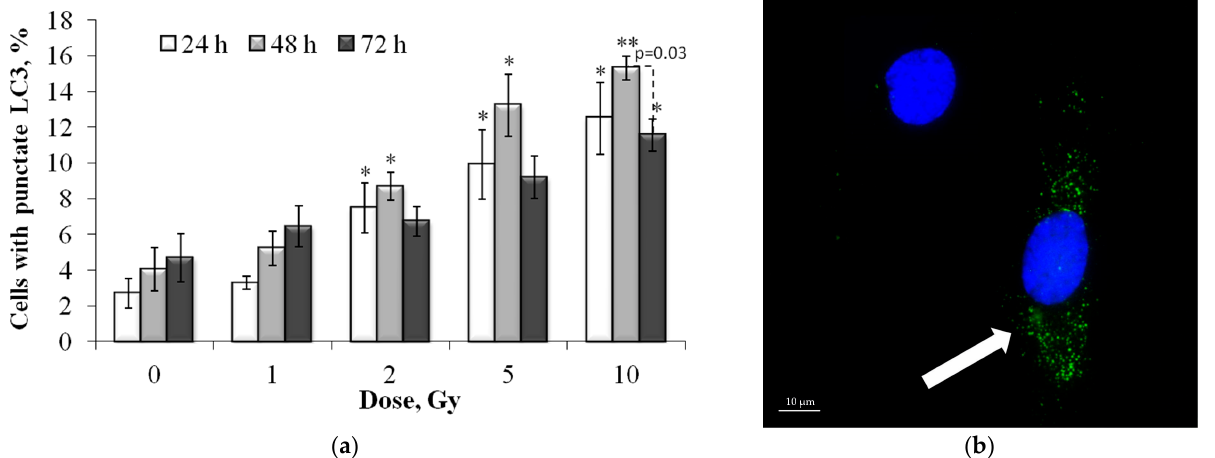
Figure 9. ( a ) Dose-dependent changes in the LC3-II positive cell fraction in human fibroblasts 24 h, 48 h and 72 h after irradiation. Data are means ± SE of three independent experiments. * p < 0.05 and ** p < 0.01—compared with the corresponding time of control; ( b ) Representative microphotograph of the immunocytochemically labeled cells with LC3-II (LC3-II positive cell with punctate LC3-II (green) is marked with the arrow). Nuclei are counterstained with DAPI (blue).